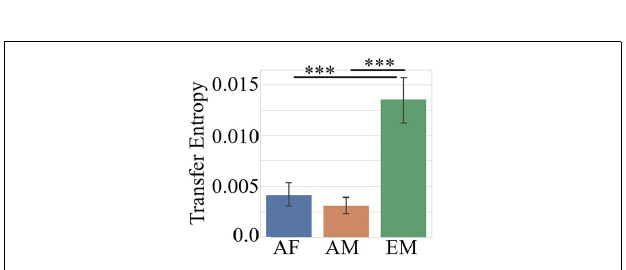
FIGURE 5 | Post hoc Wilcoxon rank sum test on combined TEs of common channels (i.e., F3, F2, C2, P5, P6, and PO3) between AF, AM, and EM settings. The data represent the averaged TEs, per common channel, per setting. In this figure, the asterisks mark significant differences between the settings ( ∗∗∗ p <